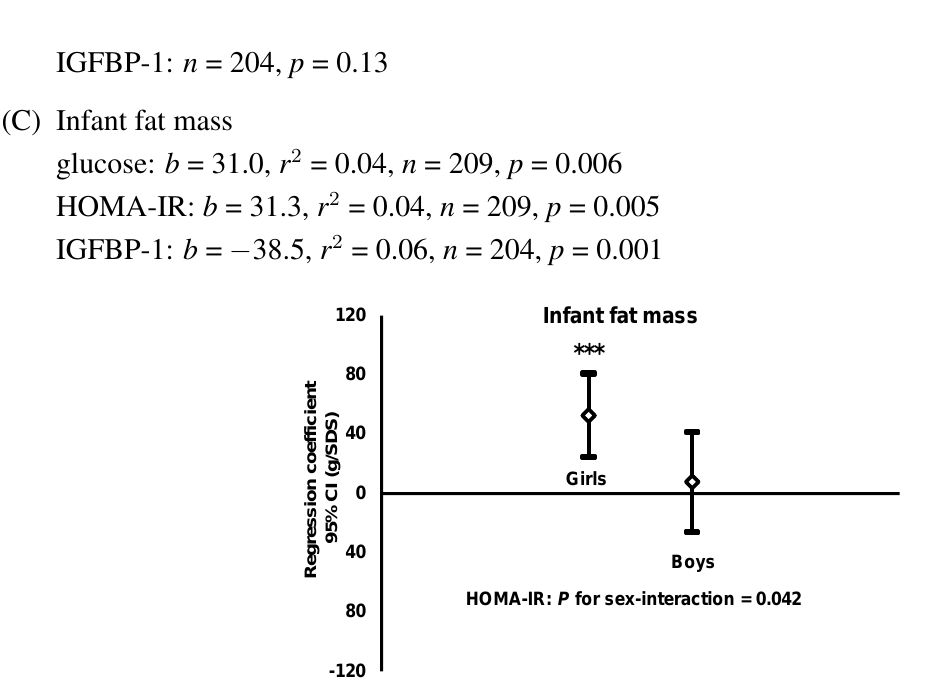
Figure 2. Fat mass (g) of one-week-old girls and boys (dependent variables) regressed on HOMA-IR, expressed as standard deviation score (SDS), of their mothers when pregnant in gestational week 32 (independent variables). Estimates are presented as regression coefficients ( b ) in g/SDS with a 95% confidence interval (CI). Regression models were adjusted for maternal parity, infant gestational age at birth and age at measurement. HOMA-IR (homeostasis model assessment-insulin resistance). Differences between regression coefficient and zero: * p < 0.05, ** p < 0.01, *** p < 0.001. Interaction term (HOMA-IR × infant sex) obtained as described in the experimental section. HOMA-IR Girls: b = 52.7, r 2 = 0.13, n = 99, p < 0.001 Boys: b = 7.8, r 2 = 0.00, n = 110, p = Table 3. Fat mass of one-week-old girls regressed on fat mass and HOMA-IR of their mothers when pregnant in gestational week 32. (Slope of regression line ( b ) and coefficient of determination ( r 2 ), calculated from r *). Model